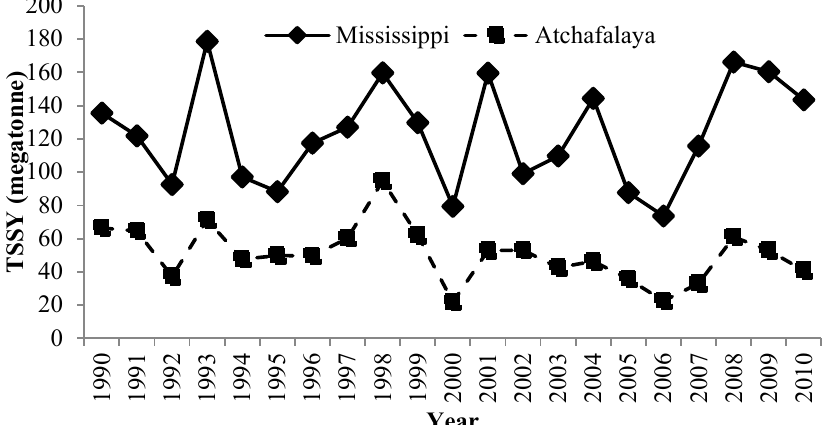
Fig. 4 Total suspended sediment yields (TSSY) of the Mississippi River at Tarbert Landing (~120 Mt year -1 ) and Atchafalaya River at Simmesport (~60 Mt year -1 ) during the recent two